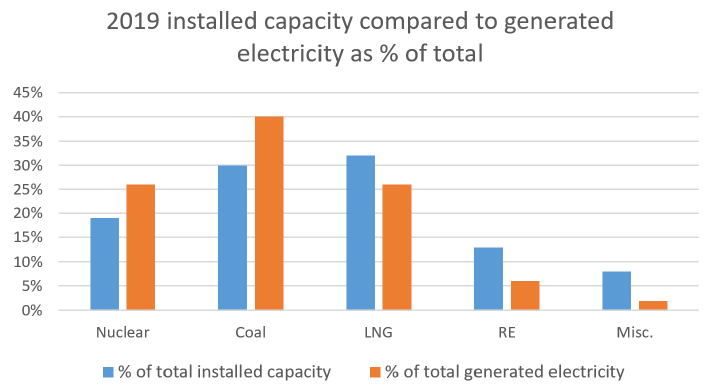
Figure 3. South Korea 2019 installed capacity compared to final energy production. Except for stated changes in the electricity generation sector, all other values, growth rates, emission factors, etc. are the same in every scenario. Table 1 provides a description